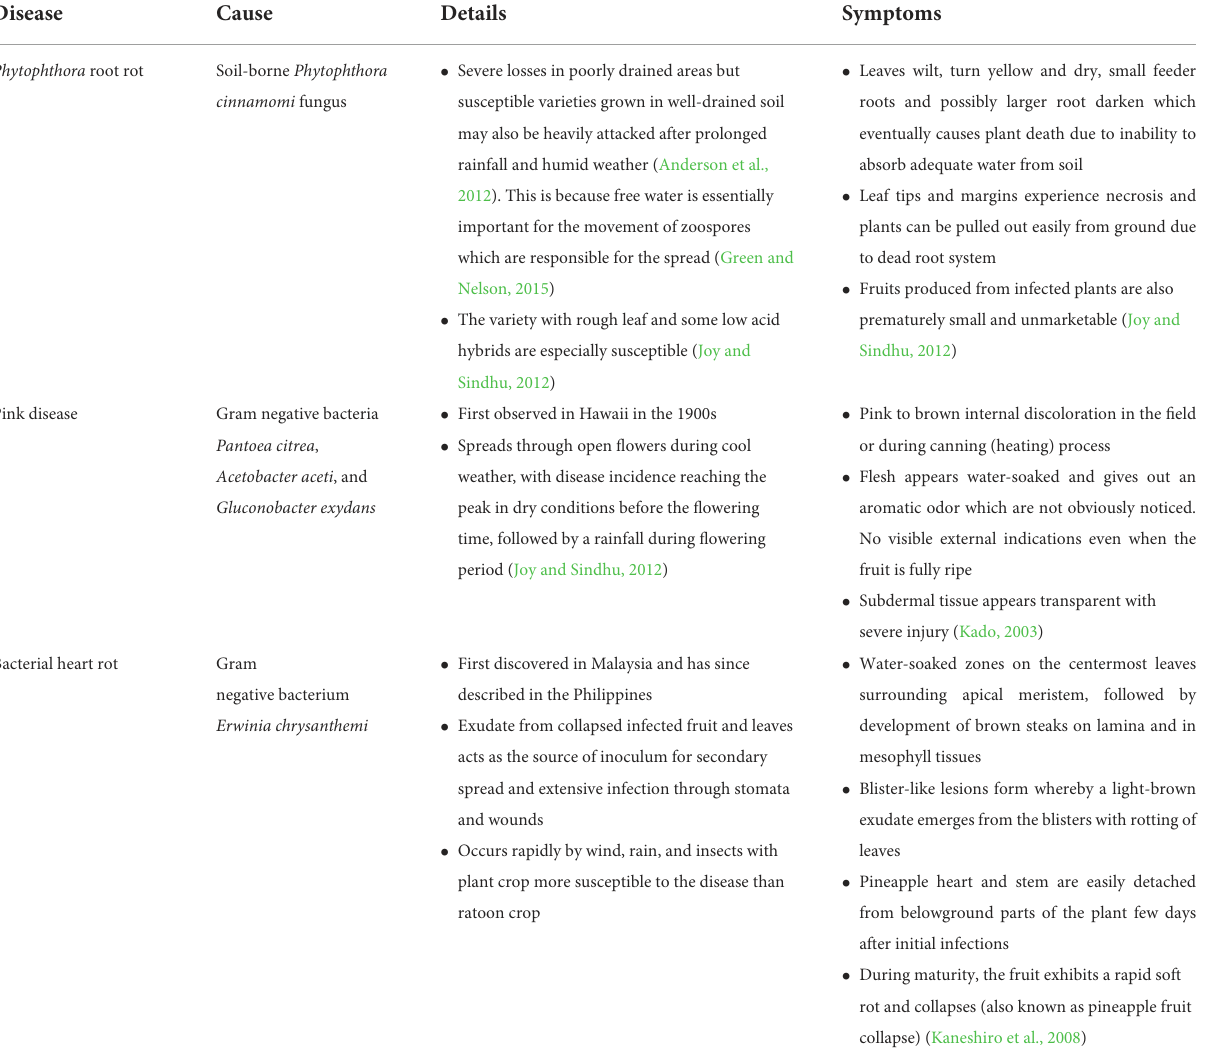
TABLE 4 A summary of major diseases affecting pineapple production.